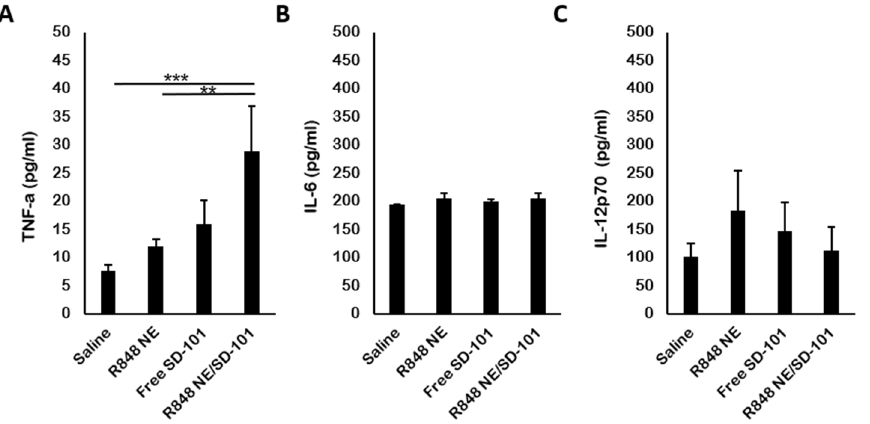
Figure 7. Induction of cytokine by TLR agonists in mice. ( A ) TNFa, ( B ) IL-6, and ( C ) IL-12p70 con- centrations were measured in mouse serum by ELISA. Serum samples were isolated from whole blood at day 10 ( n = 3). One-way ANOVA: ** p < 0.01, *** p <